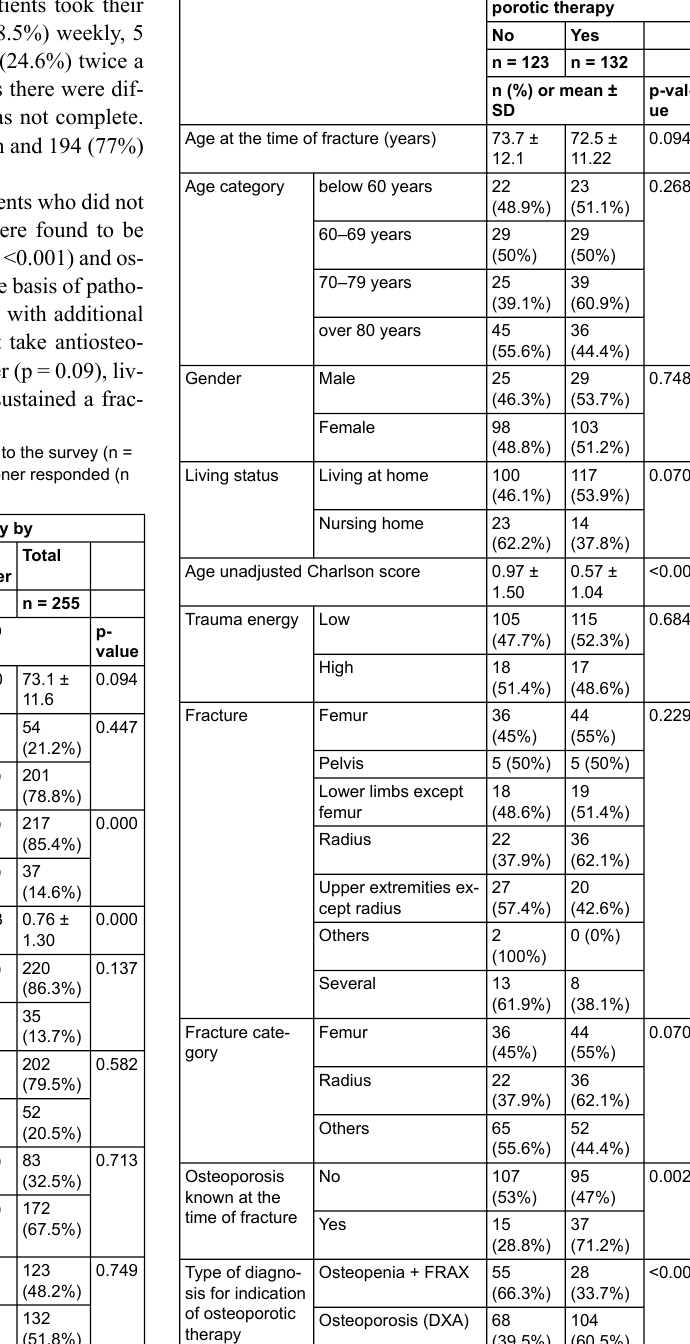
Use of specific osteo- porotic